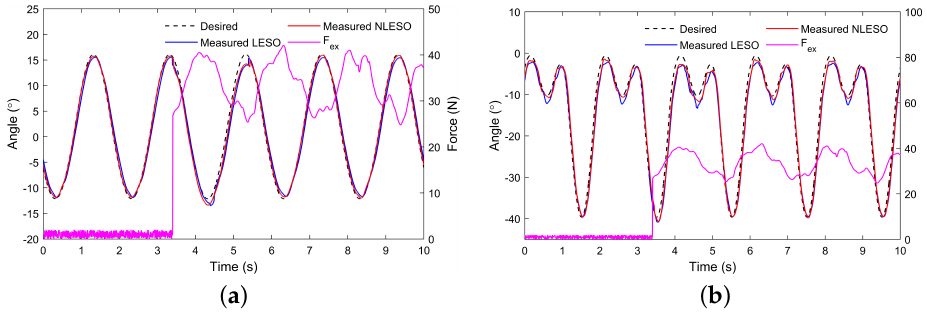
Figure 6. The system’s response to disturbance (NLESO): ( a ) hip and ( b ) knee joints. Table 3. The RMSE value of the two